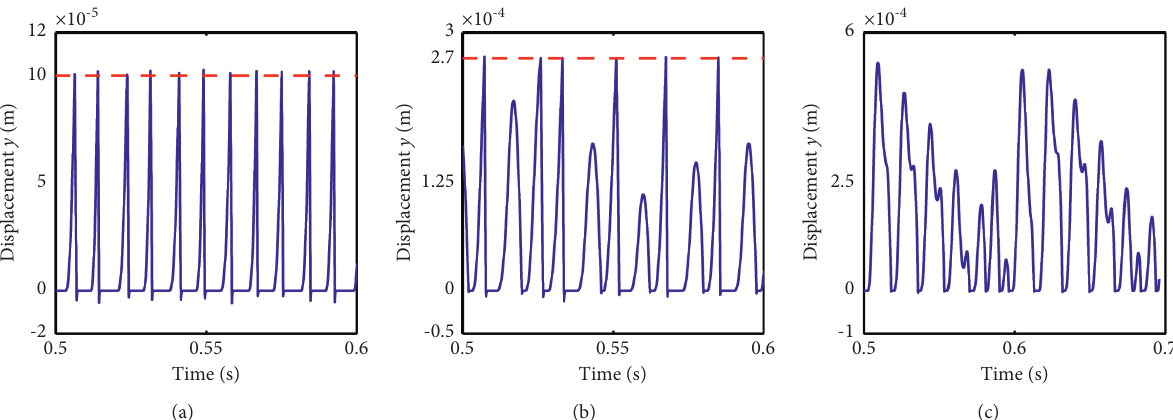
Figure 17: Vibration waveforms of the right bearing support with the change of the loose clearance. (a) δ � 0.1 × 10 –3 m, (b) δ � 0.27 × 10 –3 m, and (c) δ � 1 × 10 –3